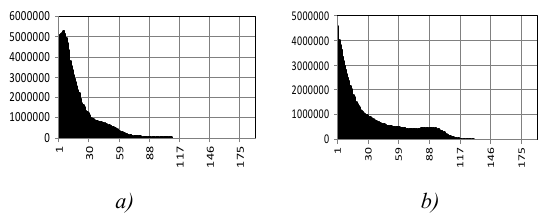
Figure 3 - Histograms of complementary pairs of difference images (Figure 2, c , d ): a - histogram changes caused by increasing brightness; b - histogram changes caused by decreasing